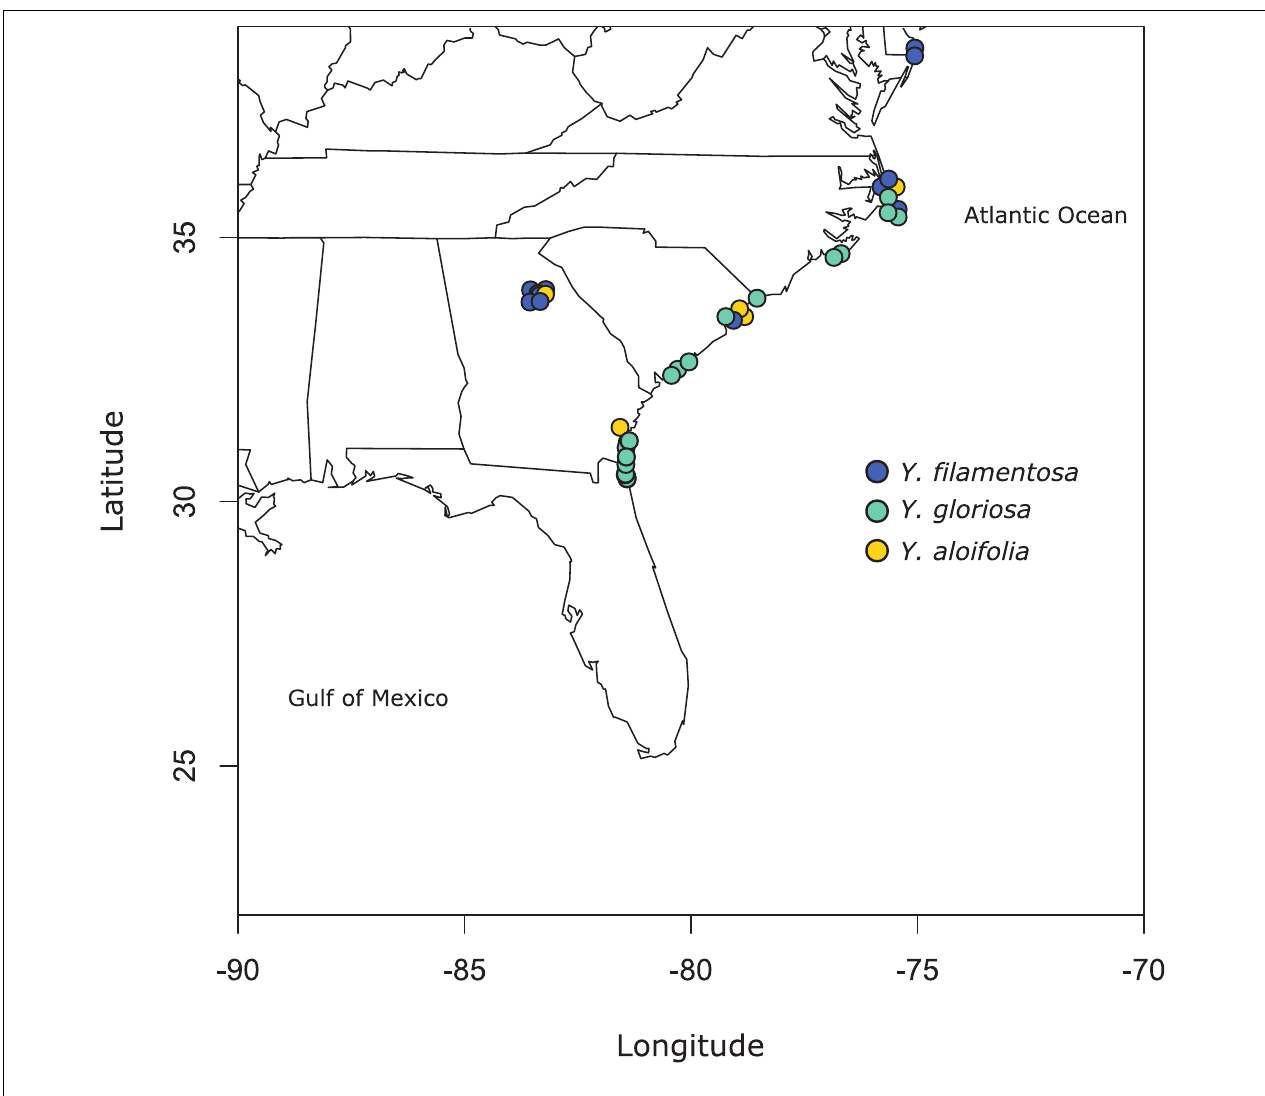
FIGURE 1 | Map of populations sampled for this study. See Supplementary Table 1 for full geographic locality